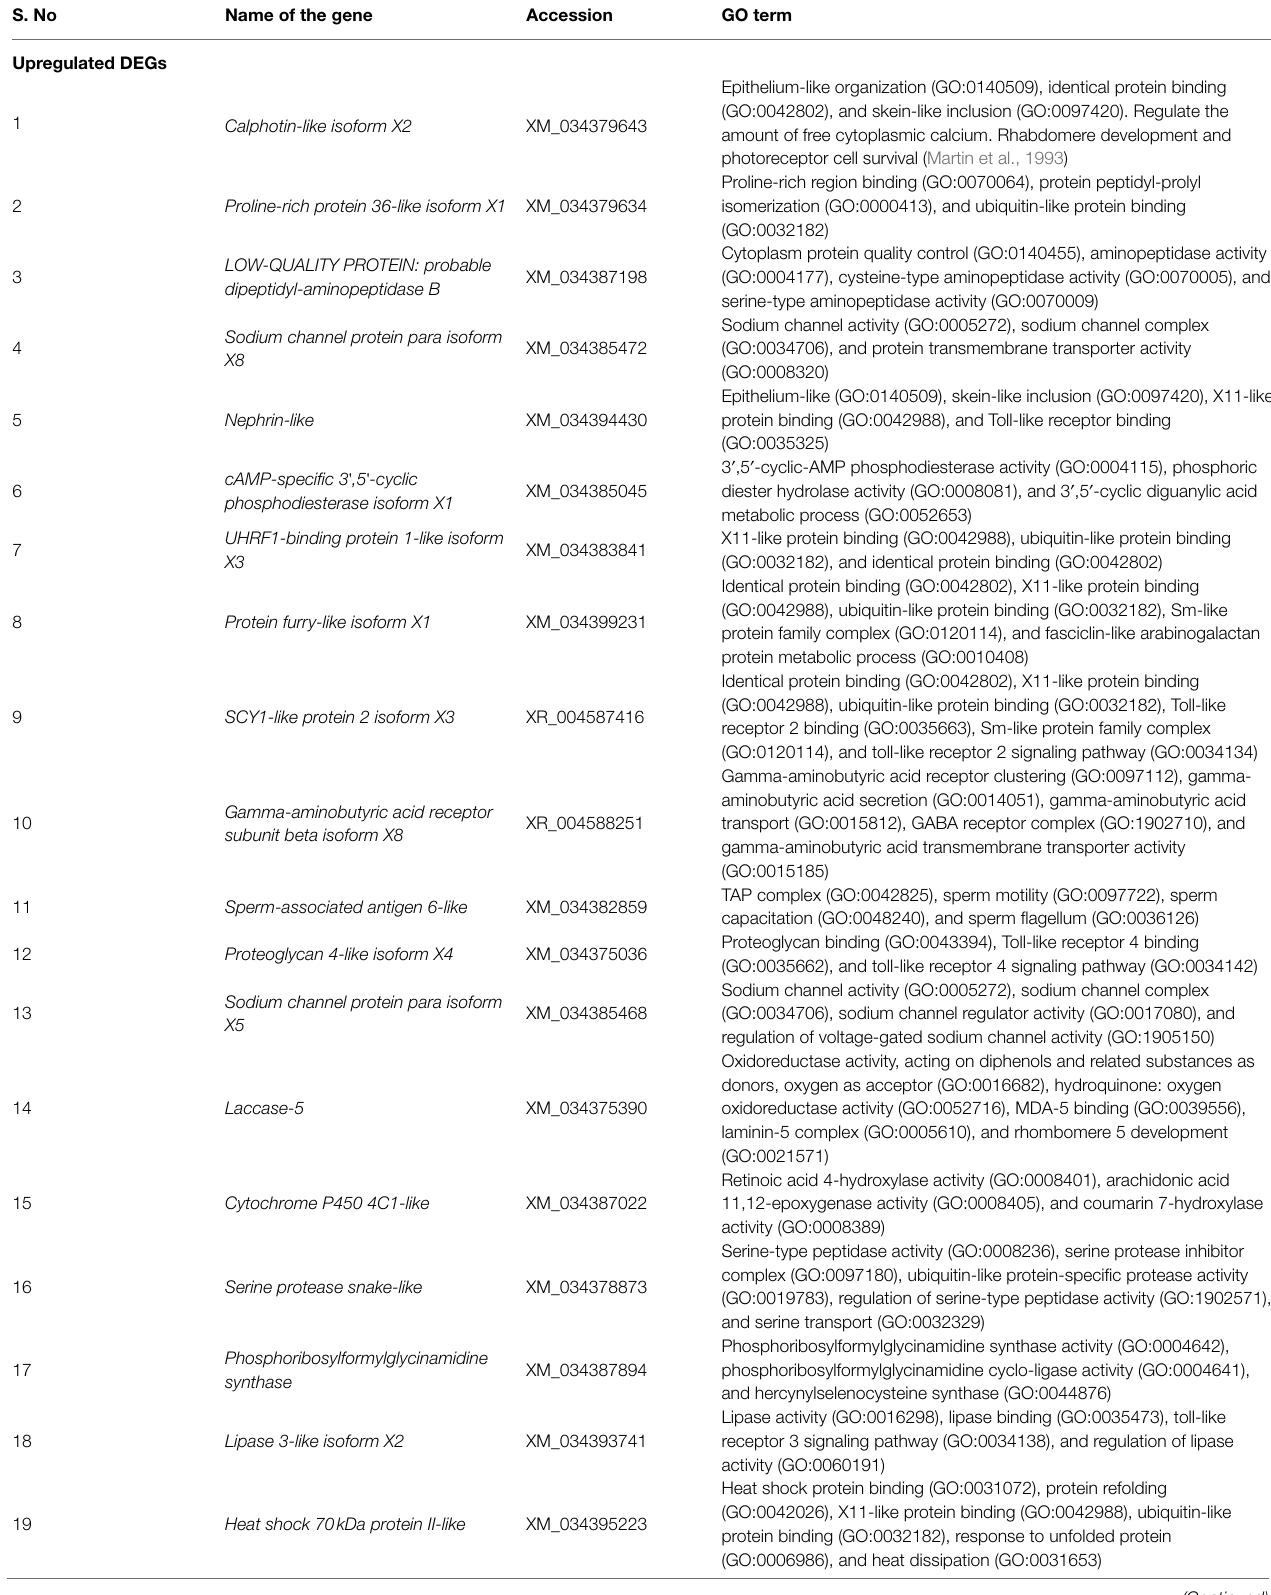
TABLE 1 | Top upregulated and downregulated genes of Thrips palmi in response to GBNV infection. S.